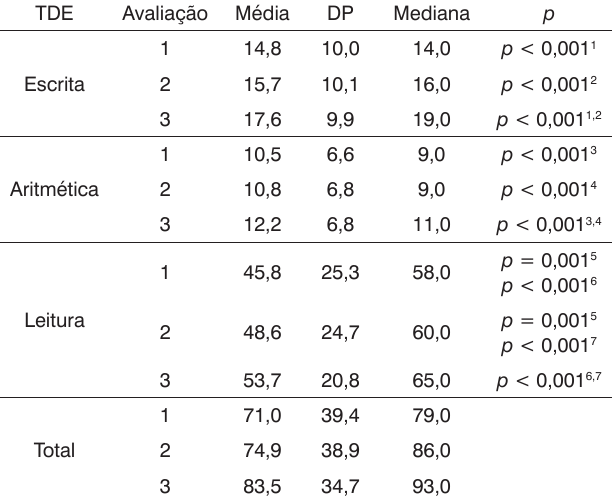
Tabela 4. Medidas resumo dos escores do Teste de Desem- penho Escolar (TDE) entre as três